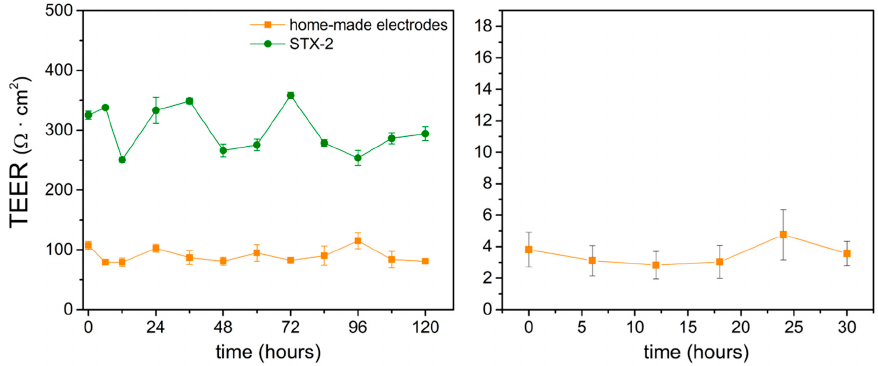
Figure 5. TEER measurement comparison of standard EVOM 2 STX2 electrodes and home-made electrodes in the Transwell ® plate ( left ) and microfluidic chip ( right ). n = 3. The TEER value reflects the physical structures and properties of endothelial cultures.